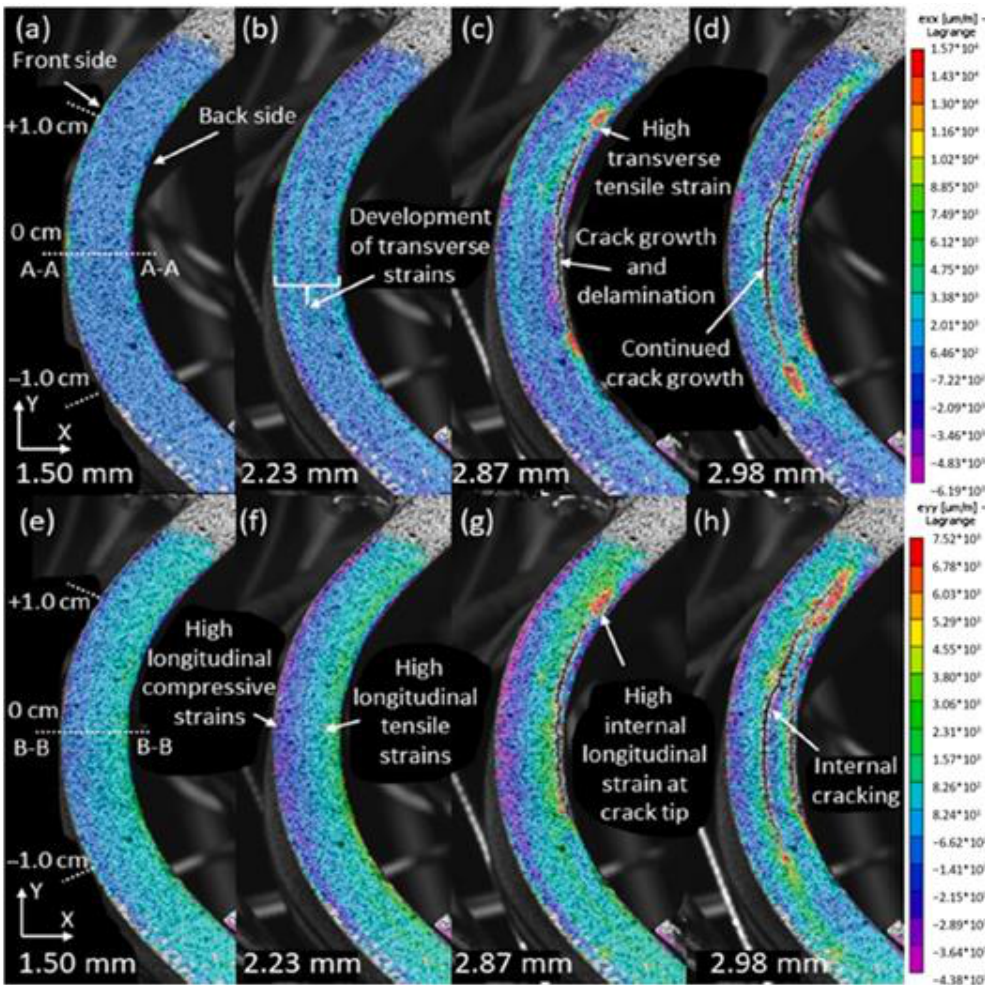
Figure 4. Visualization of damage in the static test by DIC with the corresponding strains ( a – d ) ‘e xx ’ and ( e – h ) ‘e yy ’ at different displacements [9].